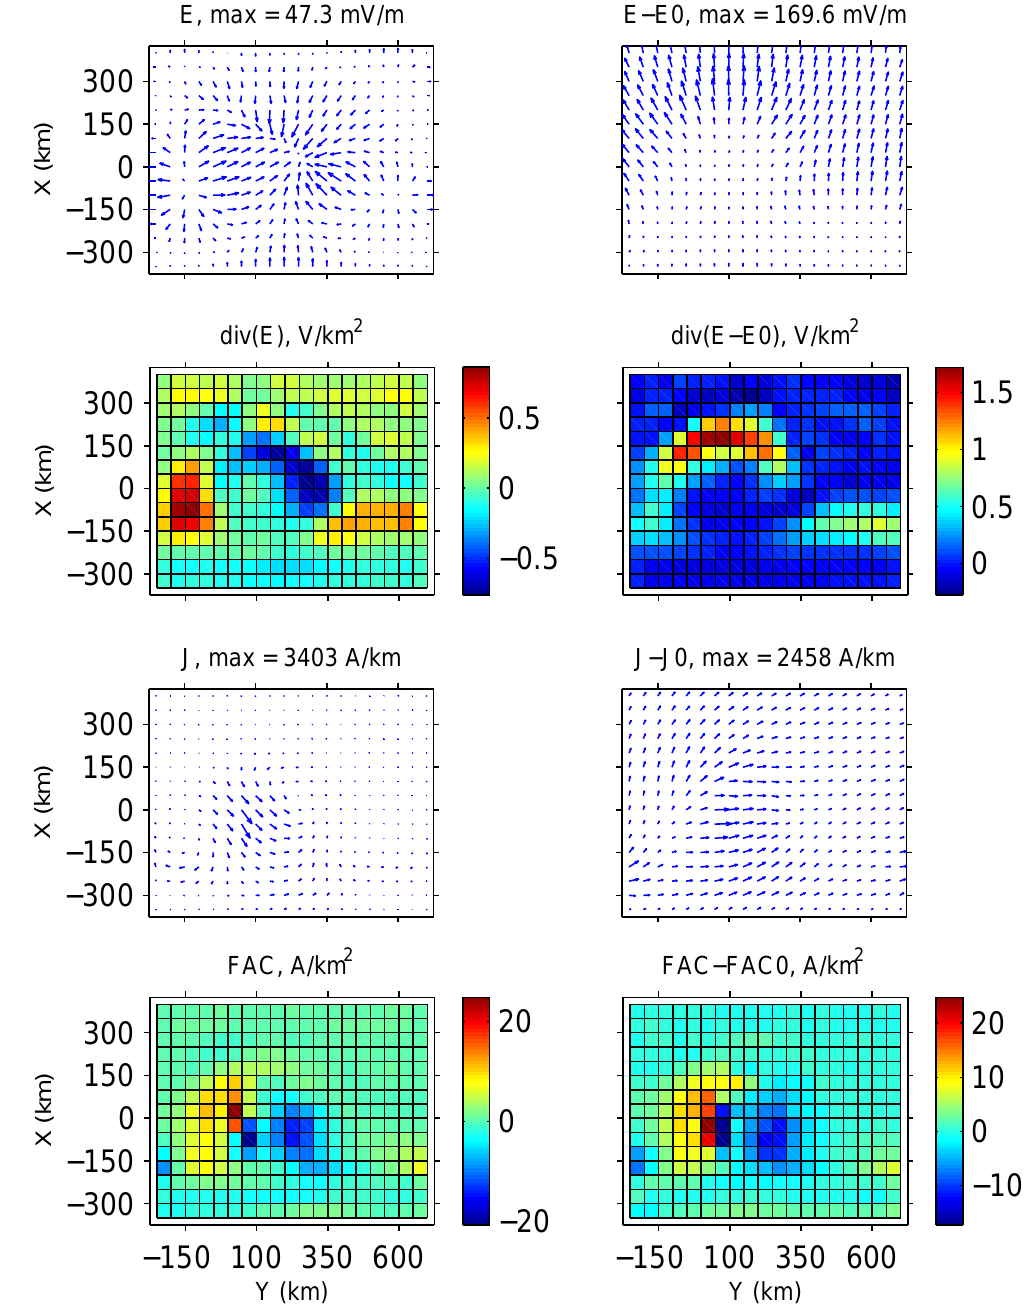
Fig. 6. KRM results for the (cid:127) -band model. Layout is similar to Fig. 3. Note the different scales of the vector plots.